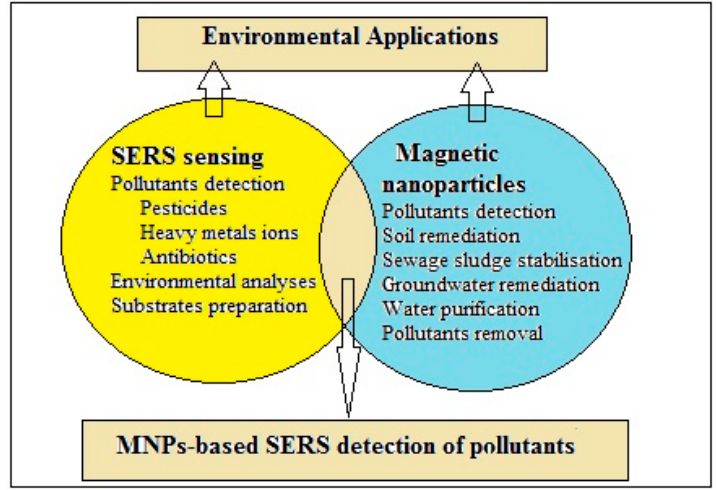
Figure 3. MNP-based SERS detection of pollutants adapted and modified from Pant et al. [39].